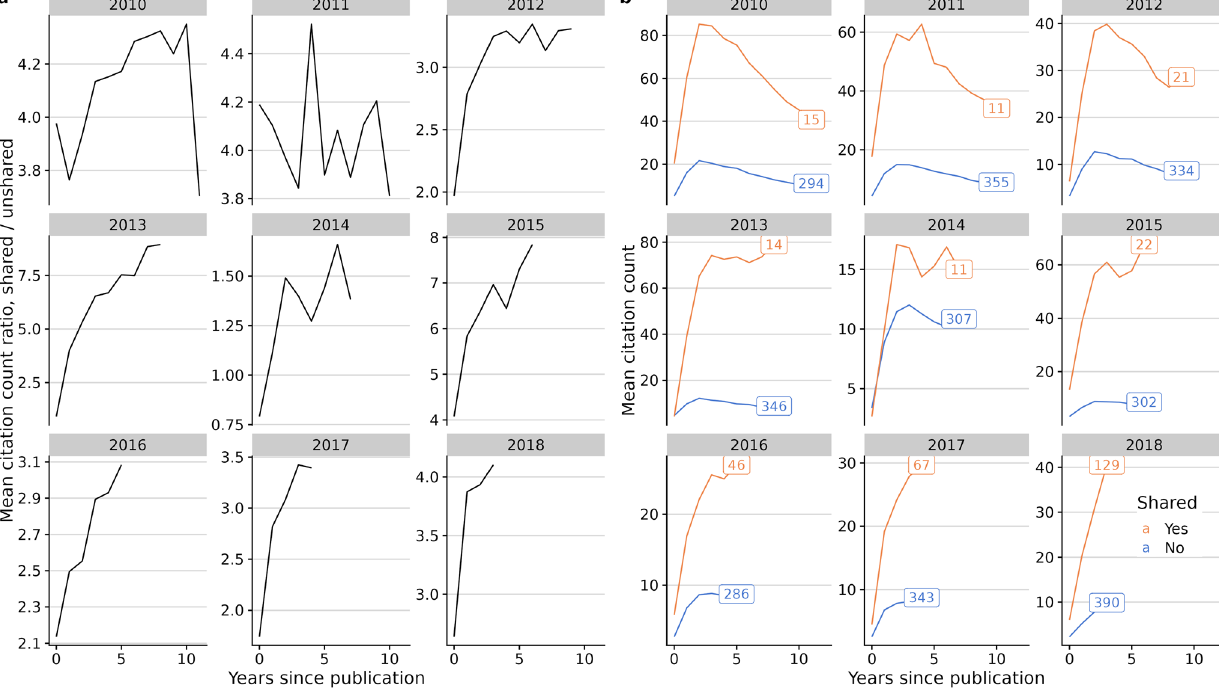
Fig. 3 Mean citation count evolution after publication, by year of publication (2010 – 2018). Sharing studies get more citations from early on, then stabilising circa 2 years after publication. a Mean citation count ratio (shared/unshared). b Sharing (orange) and non-sharing (blue) mean citation count. Text in squares indicates the number of studies in each